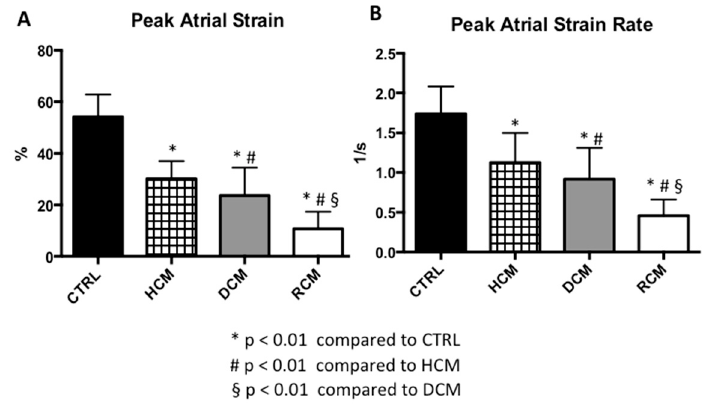
Figure 3. Comparisons of left atrial strain and strain rate values among three groups of paediatric cardiomyopathies and healthy controls. Mean and standard deviation of peak left atrial strain ( A ) and strain rate ( B ) in the study population by cardiomyopathy type. * p < 0.01 compared to CTRL. # p < 0.01 compared to HCM. § = p < 0.01 compared to DCM. CTRL: normal controls. HCM: Hypertrophic Cardiomyopathy. DCM: Dilated Cardiomyopathy. RCM: Restrictive Cardiomyopathy.